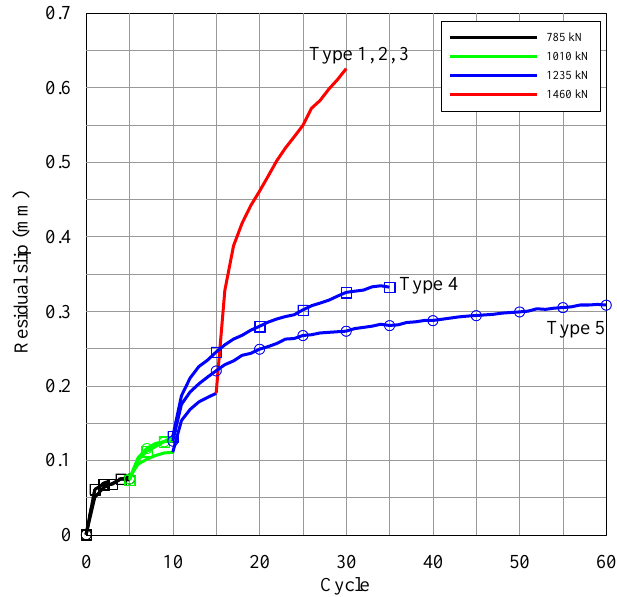
Figure 10. Cumulative residual slip curves according to load cycles.